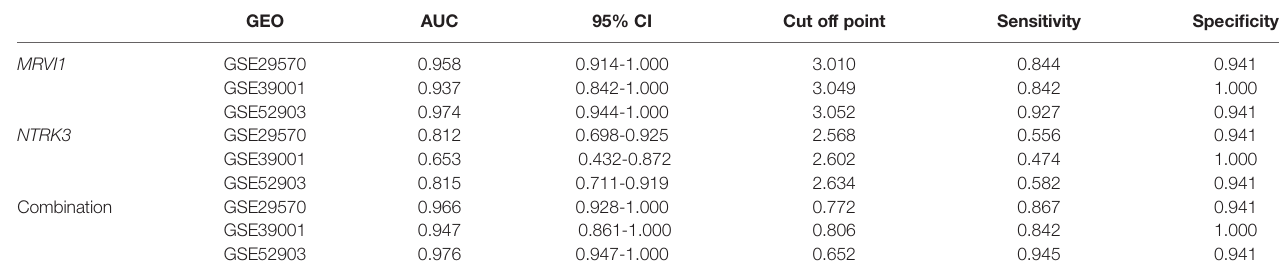
TABLE 1 | Accuracy of MRVI1 and NTRK3 for predicting the prognosis of cervical cancer